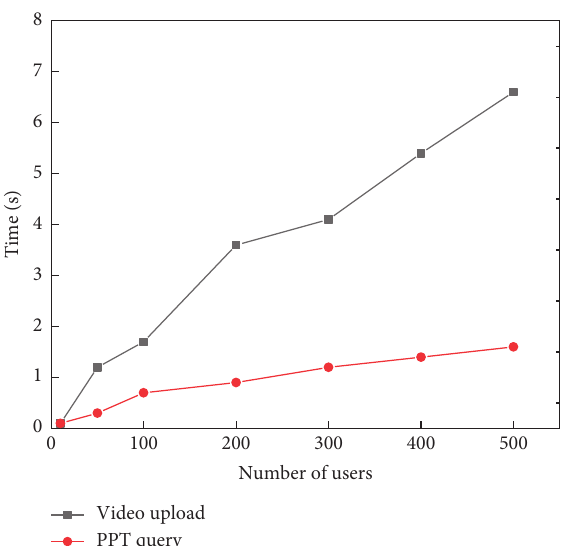
Figure 9: The maximum response time of the system running under the largest concurrent user.